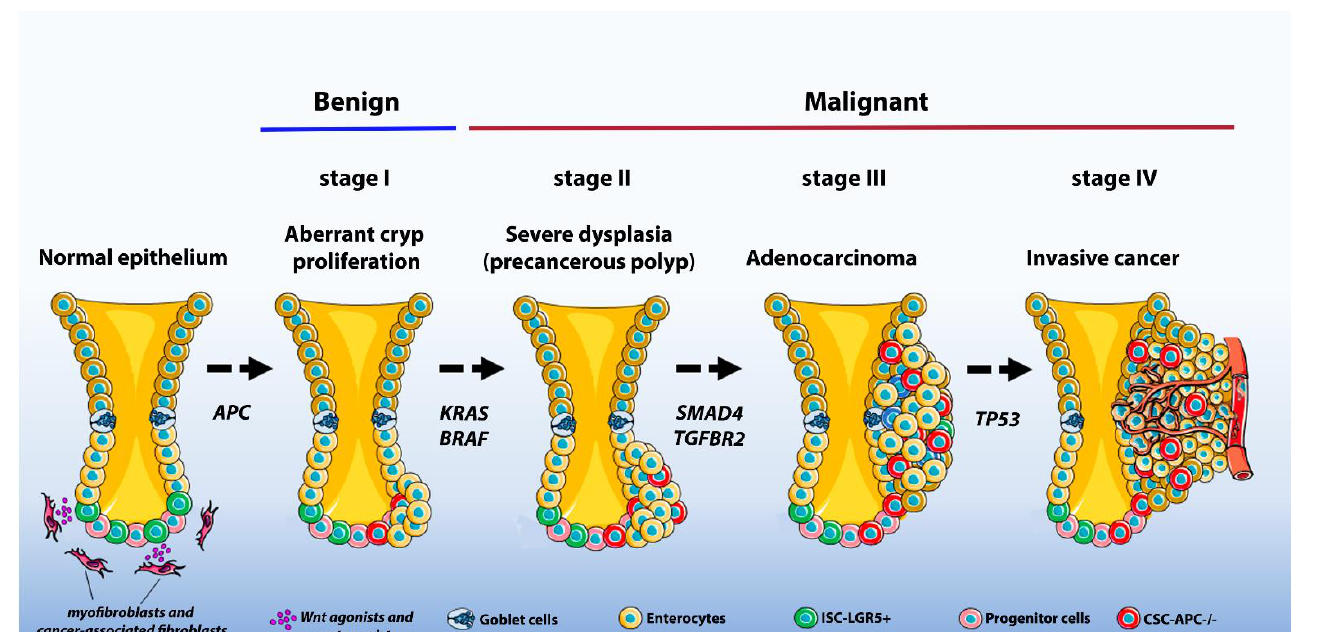
Figure 2. Schematic representation of the multistep process of carcinogenesis in the colonic epithelium with the corresponding genetic alteration in each step. The loss of APC leads to the development of tubular adenomas, which can progress to adenocarcinomas. APC, adenomatous polyposis coli; KRAS, Kirsten rat sarcoma viral oncogene homolog; BRAF, B-Raf Proto-Oncogene, Serine/Threonine Kinase; SMAD4, Mothers against decapentaplegic homolog 4; TGFBR2, Transforming Growth Factor Beta Receptor 2; TP53, tumor protein p53.